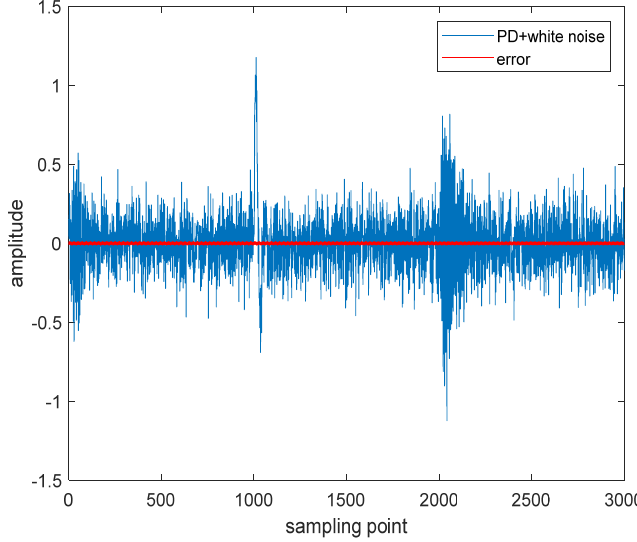
Figure 13. PD signal after removal of sinusoidal noise and the error.